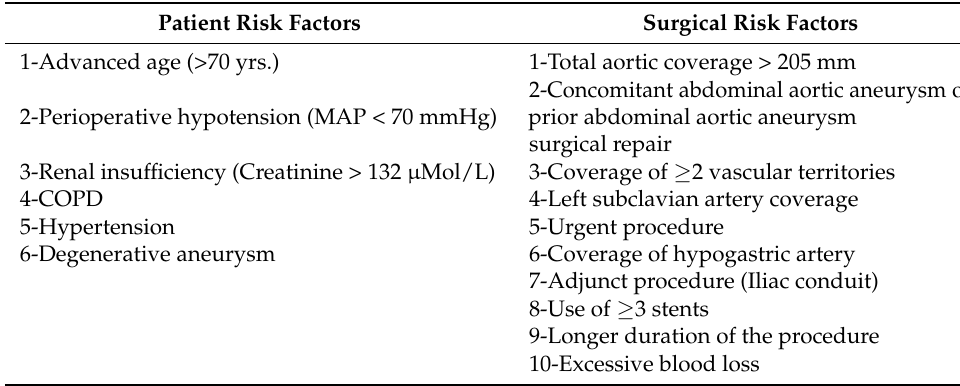
Table 1. Risk factors for susceptibility of spine cord ischemia after thoracic aortic repair 1 . Patient Risk Factors Surgical Risk